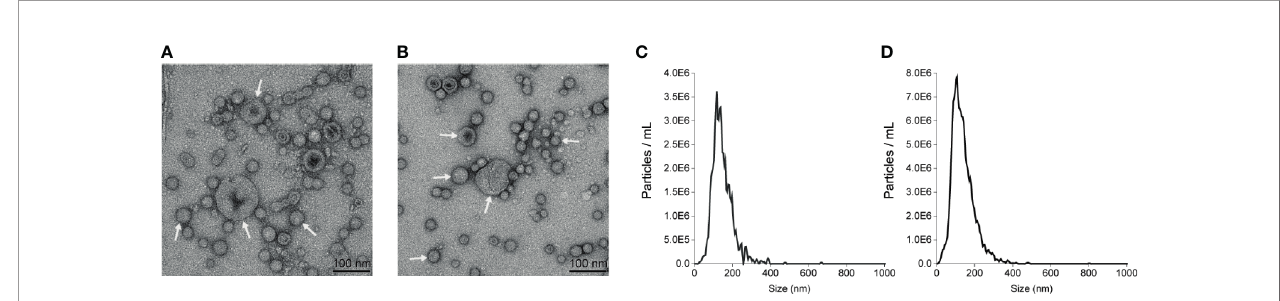
FIGURE 1 | Representatives of transmission electron microscopy images of E coli 08-85 OMVs (A) and E coli K12 OMVs (B) recorded with negative staining with 2% phosphotungstic acid. The size distribution of OMVs of E. coli 08-85 (C) and E coli K12 OMVs (D) observed by nanoparticle tracking analysis. The OMVs were free of contaminating bacteria and the diameter ranged from 40 to 200